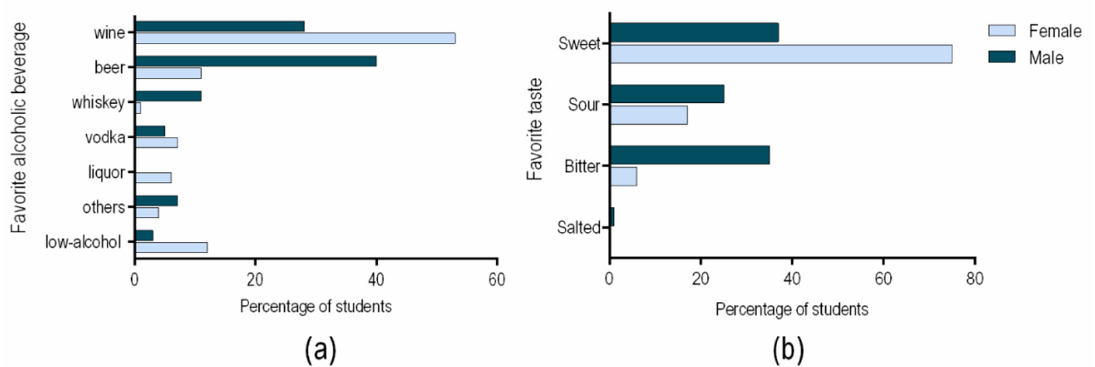
Figure 3. Students’ preferences in terms of alcoholic beverages ( a ) and tastes ( b